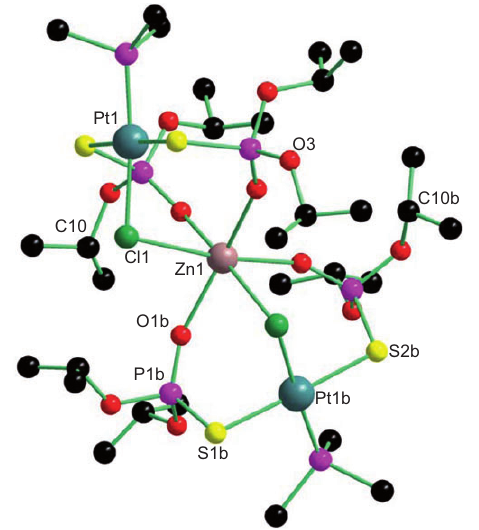
Figure 3 Structure of { [(PMe